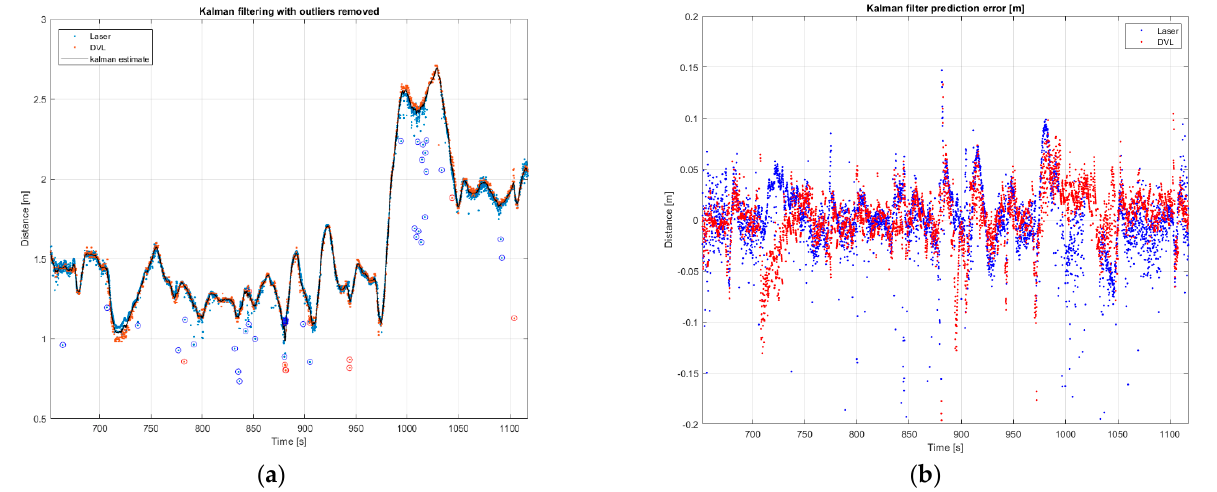
Figure 18. ( a ) shows a Kalman filter fusion of the distance measurements, with outliers removed. The outliers are indicated with circles. ( b ) Shows the Kalman prediction error which is the basis for estimating the noise levels for the two sensors.